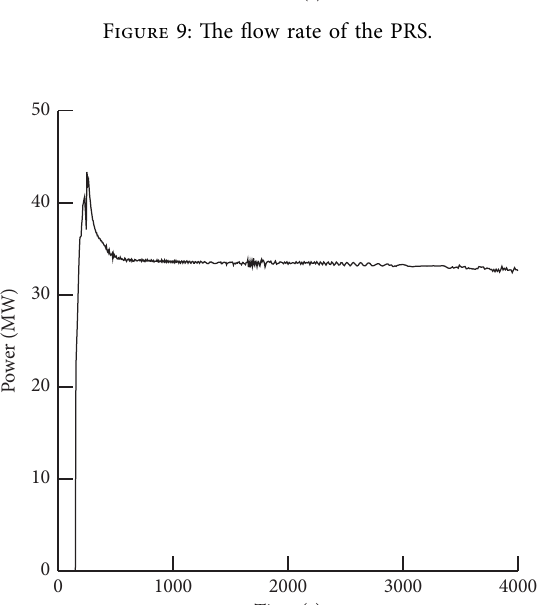
9: The flow rate of the PRS.